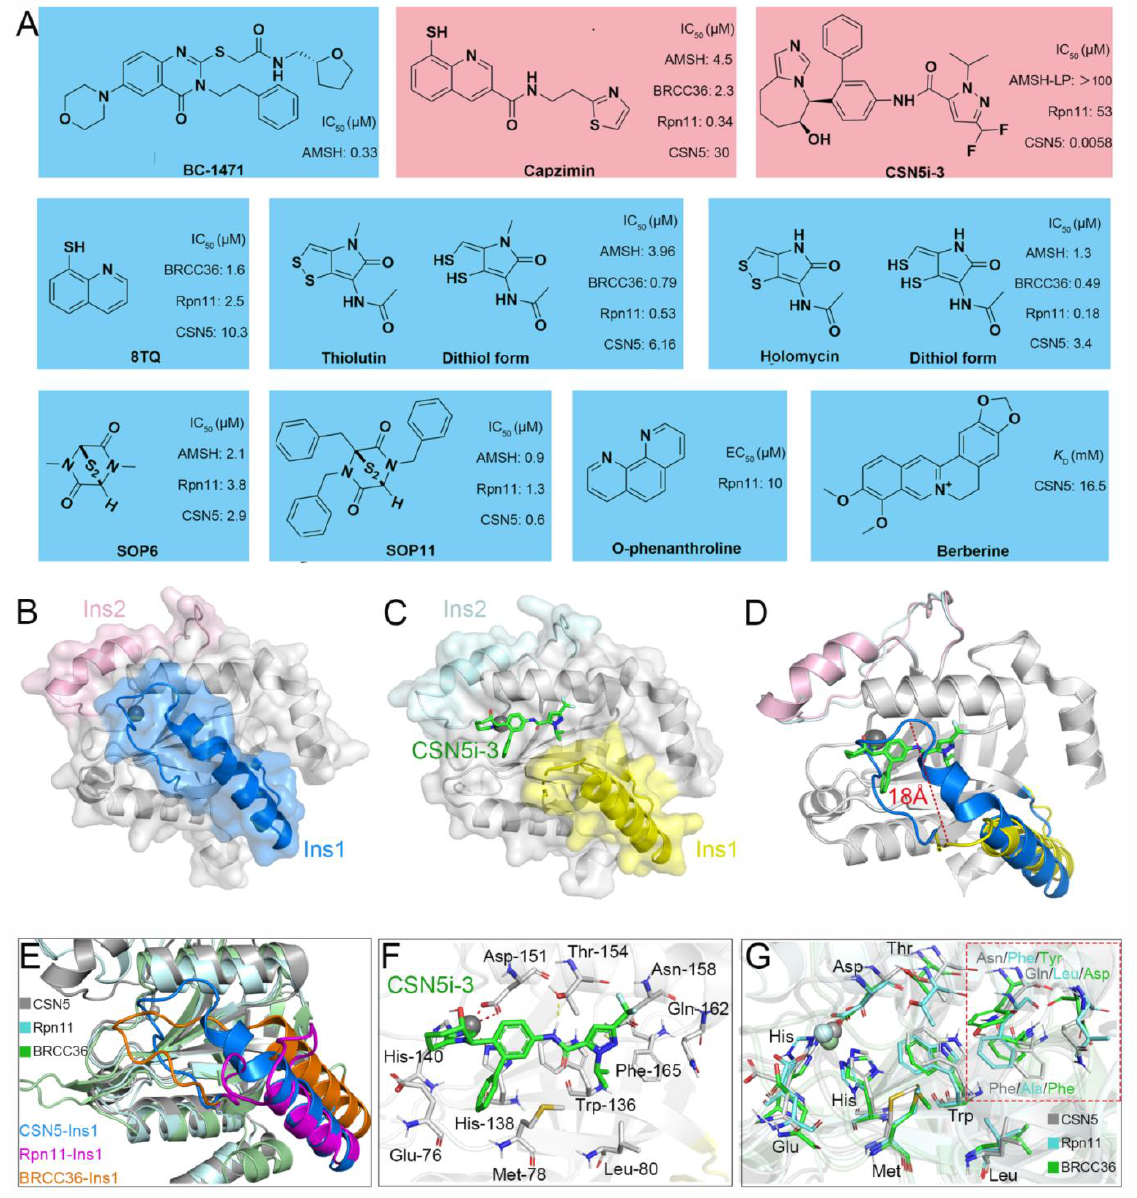
Figure 8. ( A ) Previously reported JAMM inhibitors. The Rpn11-specific inhibitor capzimin and CSN5-specific inhibitor CSN5i-3 are colored red. ( B ) Crystal structure of CSN5 (PDB ID: 4D10). The Ins-1 and Ins-2 are colored blue and pink, respectively. ( C , F ) Crystal structure of CSN5 in complex with CSN5i-3 (PDB ID: 5JOG). The Ins-1 and Ins-2 are colored yellow and palecyan, respectively. The CSN5i-3 is colored light green. ( D ) Superposition of the crystal structures of CSN5 and the complex of CSN5 and CSN5i-3. ( E , G ) Superposition of the crystal structures of CSN5, Rpn11, and BRCC36 (PDB ID: 6H3C). The CSN5, Rpn11, and BRCC36 are colored gray, cyan, and green, respectively. The Ins-1 regions of CSN5, Rpn11, and BRCC36 are colored blue, purple, and orange, respectively.